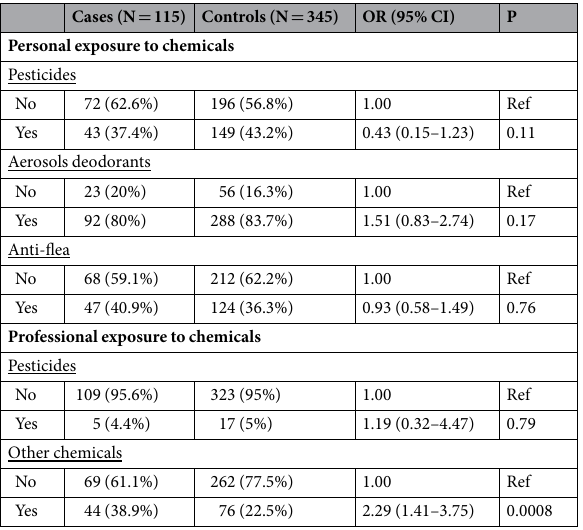
Table 2. Sex- and age-adjusted Odds Ratios (ORs) and 95% confidence intervals (CI) between each chemical exposure variables and EMAP status (115 cases vs 345